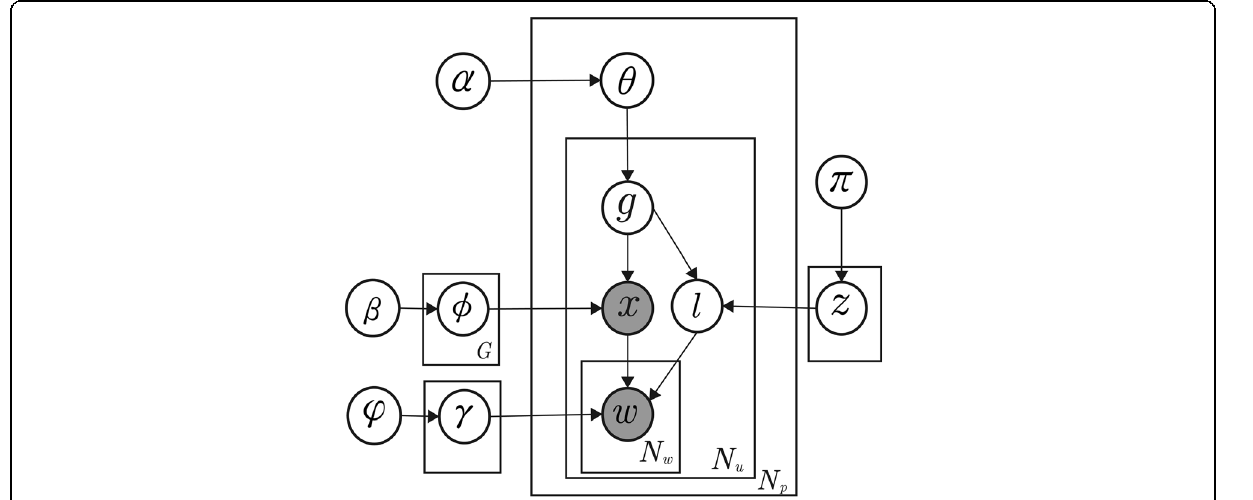
Fig. 2 Proposed Group Topic-Author